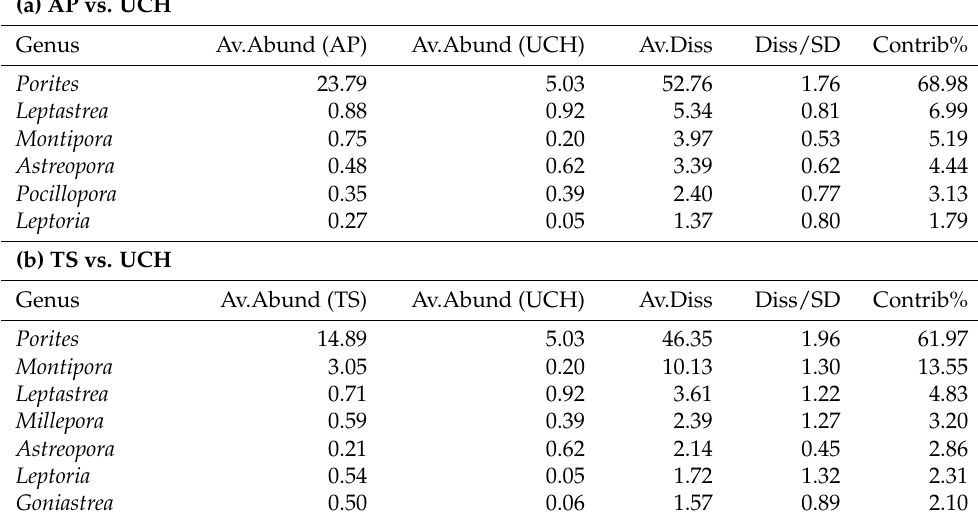
Table 2. List of coral genera that contributed to ≈ 90% of cumulative dissimilarity between coral assemblages on natural reefs and artificial substrata based on SIMPER analysis on the Bray–Curtis dissimilarity for (a) the AP region vs. the UCH sites and (b) the TS region vs. the UCH sites. The heading of each column shows “Av.Abund”, average cover (%); “Av.Diss”, average dissimilarity contribution; “Diss/SD”, ratio of the average dissimilarity contribution to the standard deviation of dissimilarity contribution; and “%Contrib”, percentage of the contribution by the genus to the between-group dissimilarity.